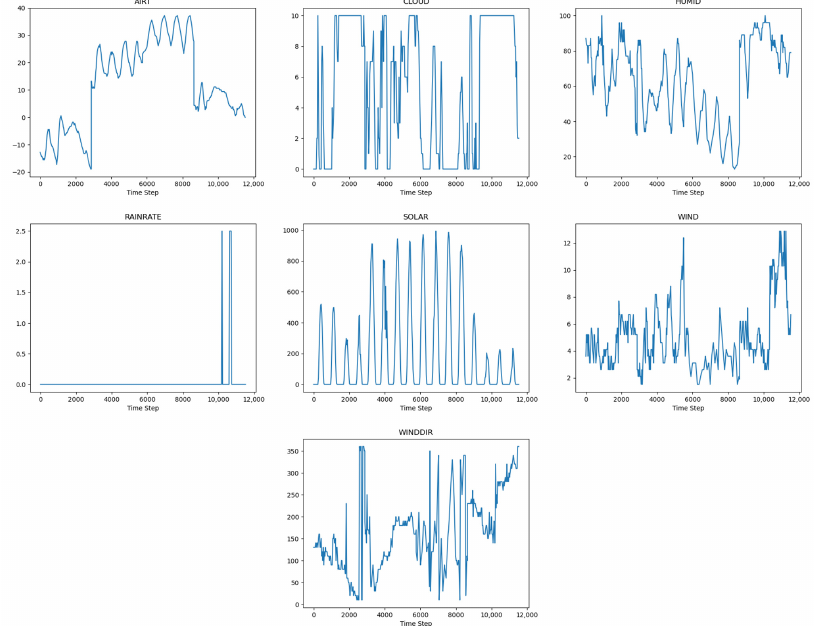
Figure 7. External meteorological parameters for temperature field prediction. Parameters from the left to right and top to bottom are atmospheric temperature, cloud cover, relative humidity, rainfall rate, solar radiation, wind speed, and direction.